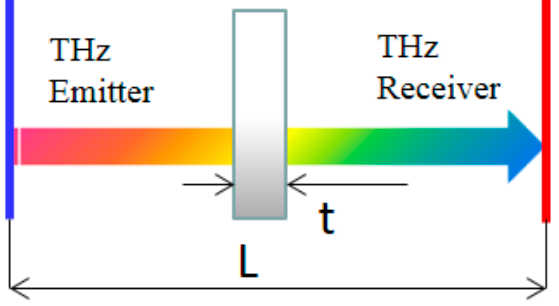
Figure 1. Schematic setup of terahertz wave (T-ray) testing in the through-transmission mode.